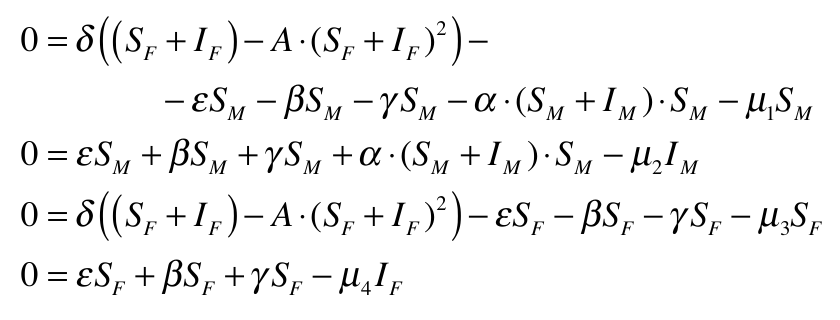
Figure 3. Estimated parameters of the model.